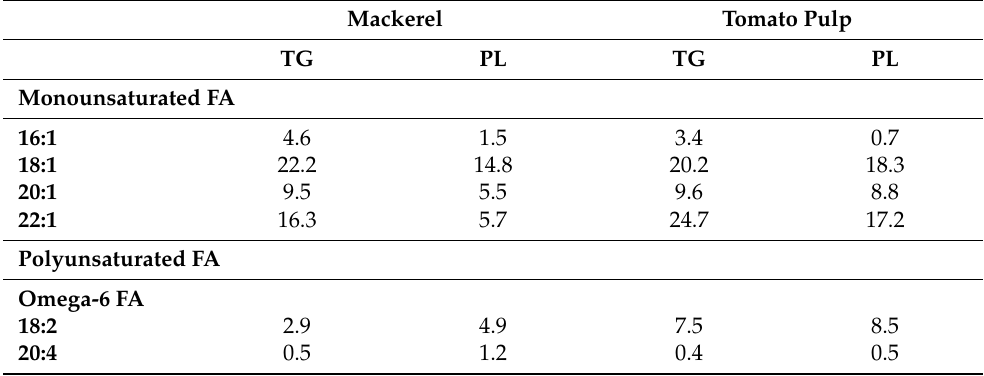
Table 2. Saturated, monounsaturated and polyunsaturated FA (%) of TG and phospholipids (PL) of canned mackerel fillet pickled in tomato pulp, modified after [17].